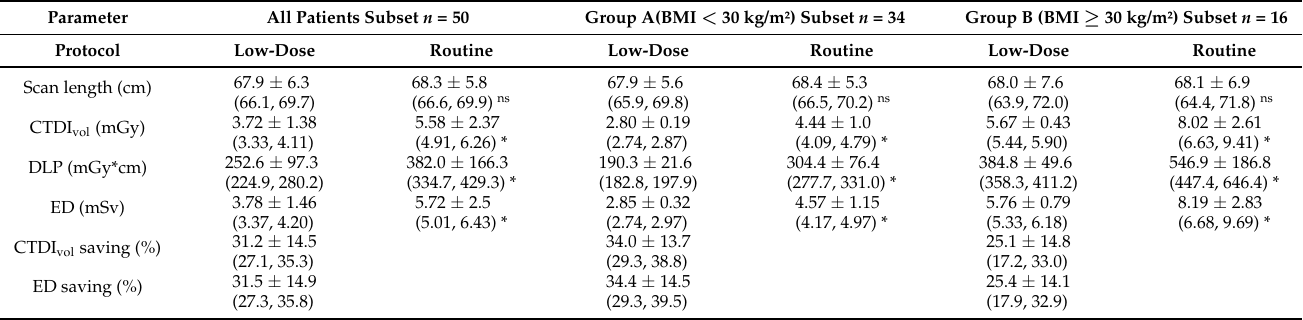
Figure 3. Boxplot diagrams of CTDI vol ( a ) and effective dose ( b ) for the two groups, including bar charts of the scan length (in b ). Values given for the low-dose CTA in the total study cohort (light blue), the low-dose CTA in the subpopulation of the intraindividual comparison (mid blue) and the clinical routine CTA in the subpopulation of the intraindividual comparison (dark blue). *** p < 0.001, ns = not significant. BMI = body mass index, CTDI vol = Volumetric CT dose index. Table 6. Intraindividual comparison of radiation dose between the low-dose and the clinical routine CTA